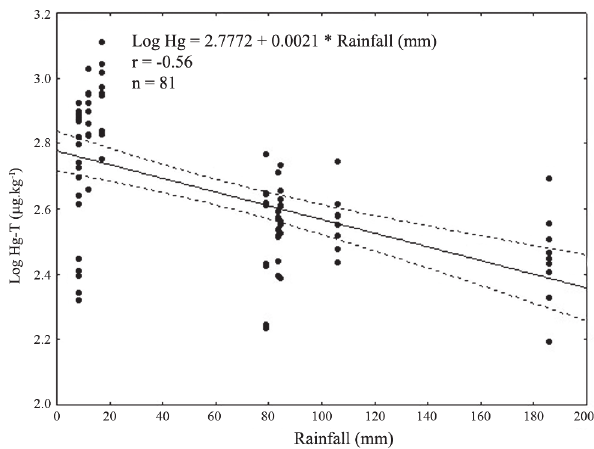
Fig. 5. Correlation (n = 81) between rainfall (mm) and log (µgHg-T.kg -1 in the muscle) of Trichiurus lepturus from